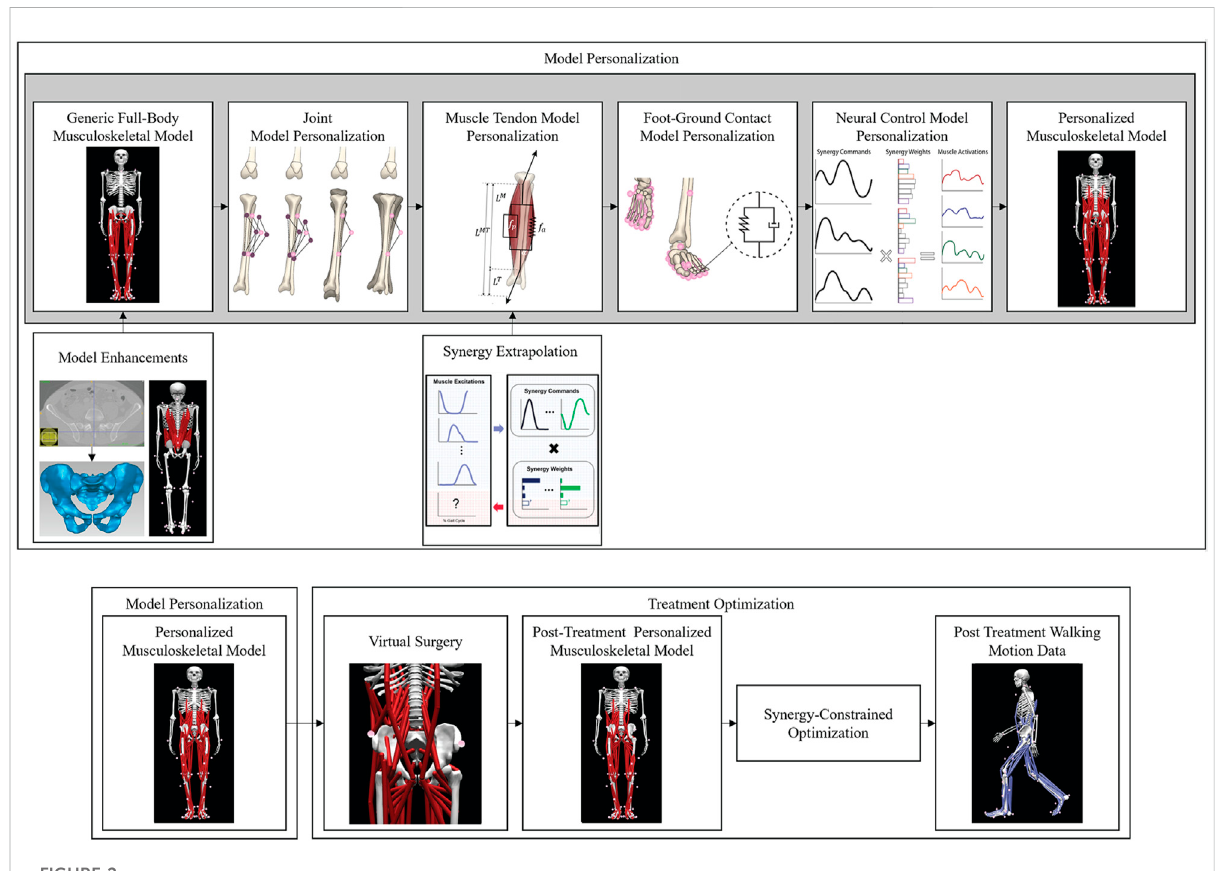
FIGURE 2 Overviewofthecomputationalprocessesusedformodelpersonalizationandtreatmentoptimization.Toprow:Modelpersonalizationprocess. Bottom row: Treatment optimization